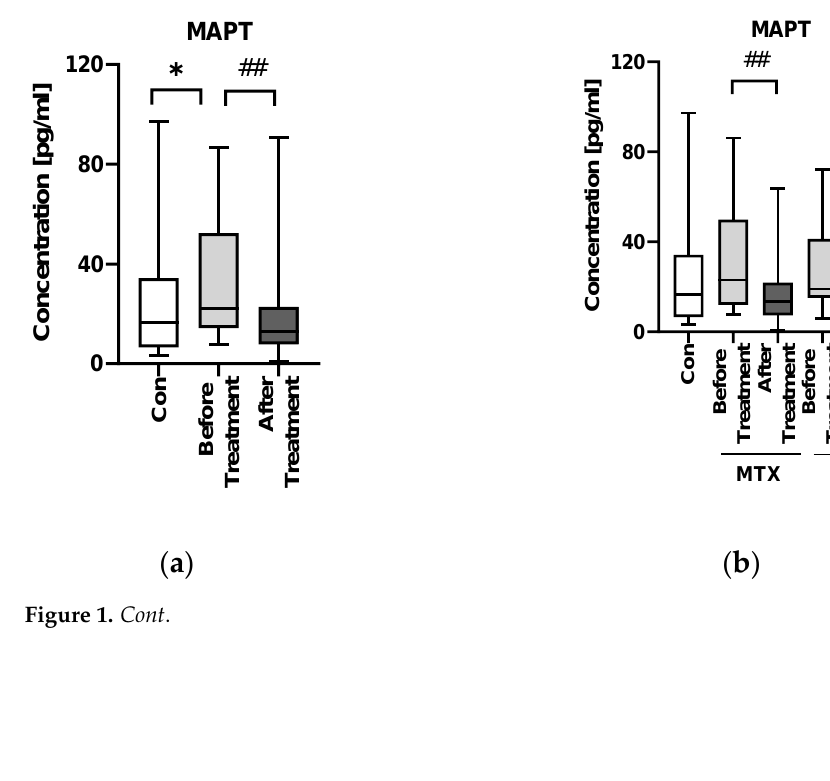
Table 1. Baseline characteristics of patients and controls.